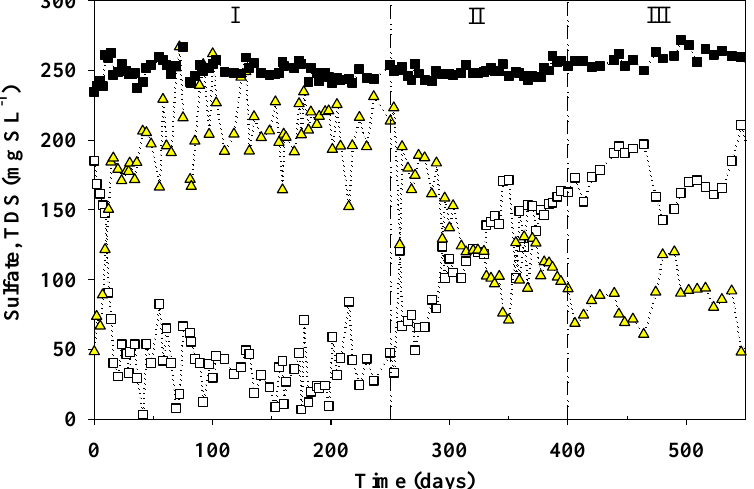
Figure 1. UASB performance during the long-term operation at constant sulfate loading rate. Sulfate concentration in the influent ( ) and in the effluent (□), total dissolved sulfide concentration in the effluent ( ) . Vertical lines represent the different periods.